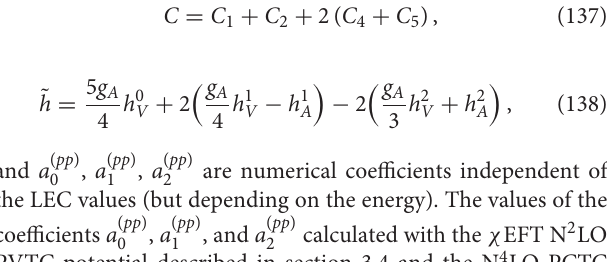
p - p 2 for the E ≤ 2.7 10 − 7 = ×